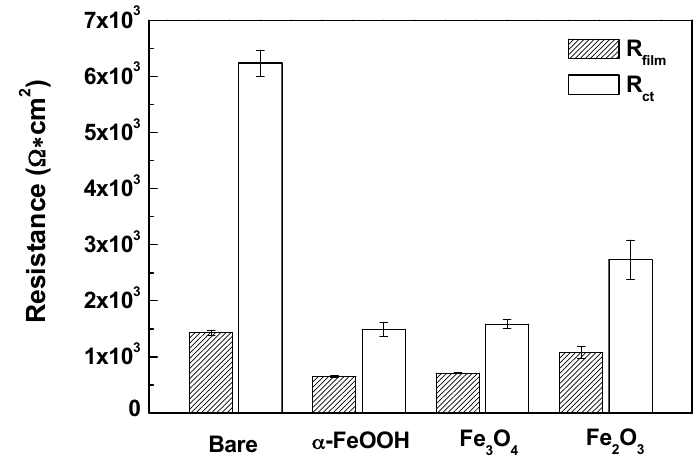
Figure 6. R film and R ct of the specimens covered with different iron oxides ( α -FeOOH, Fe 3 O 4 , Fe 2 O 3 ) and uncovered after 6 h immersion in the simulated district heating water at 40 °C.